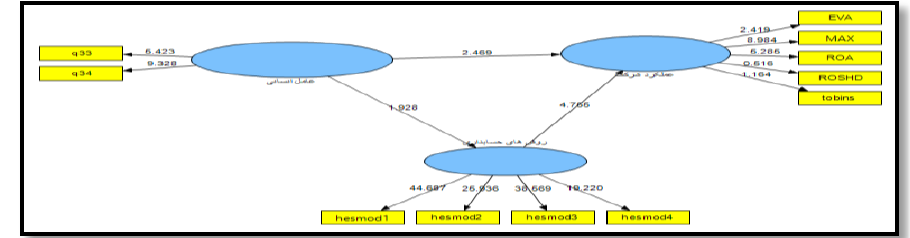
Figure 9. The model path coefficient